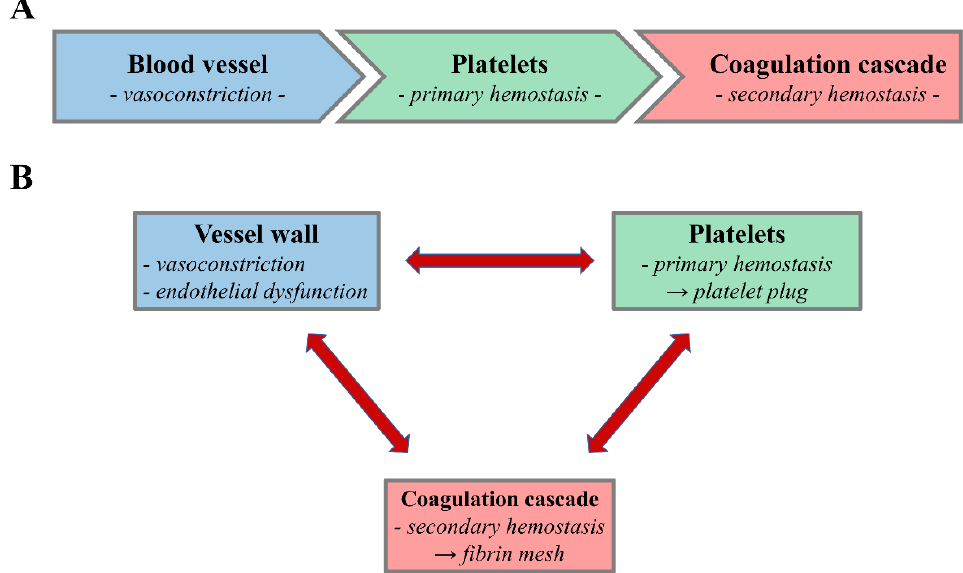
Figure 1. Schematic image of the hemostatic process. ( A ) Classic view of hemostasis as a three-step process involving vasoconstriction and primary and secondary hemostasis as independent and sequential events. ( B ) Current view of hemostasis as a complex process in which the vessel wall, the platelets, and the coagulation system collaborate and continuously influence one another.